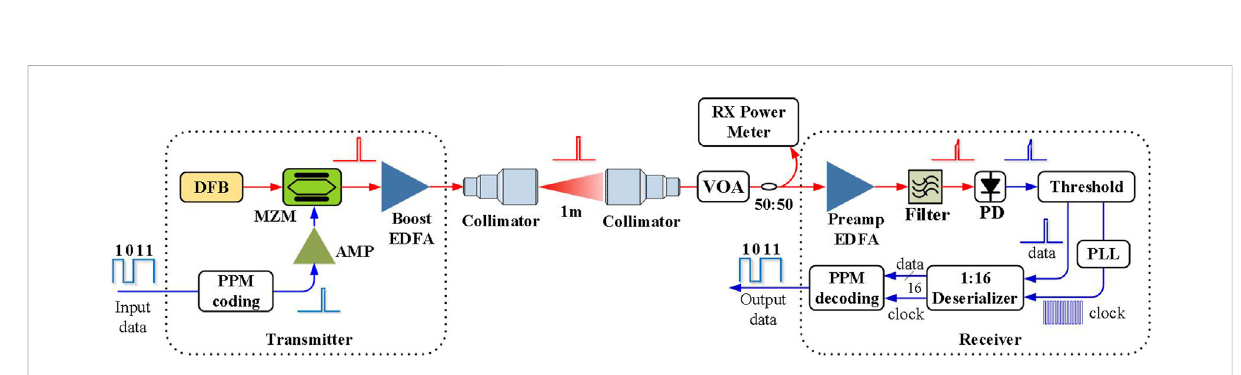
FIGURE 3 Schematic diagram of the preampli fi ed thresholded M -PPM system. DFB: distributed feedback; MZM: Mach – Zehnder modulator; AMP: ampli fi er; EDFA: erbium-doped fi ber ampli fi er; VOA: variable optical attenuator; PD: photodetector; PLL: phase-locked